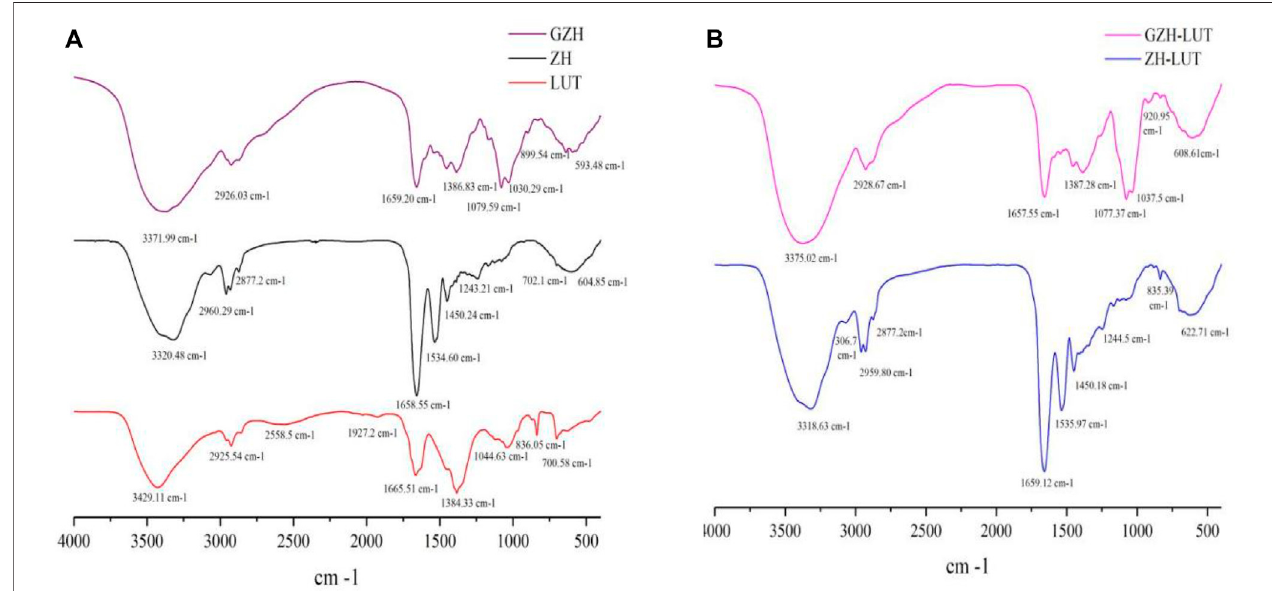
FIGURE 5 | FTIR spectra of LUT, ZH and GZH carriers (A) and ZH-LUT and GZH-LUT nanoparticles (B) .